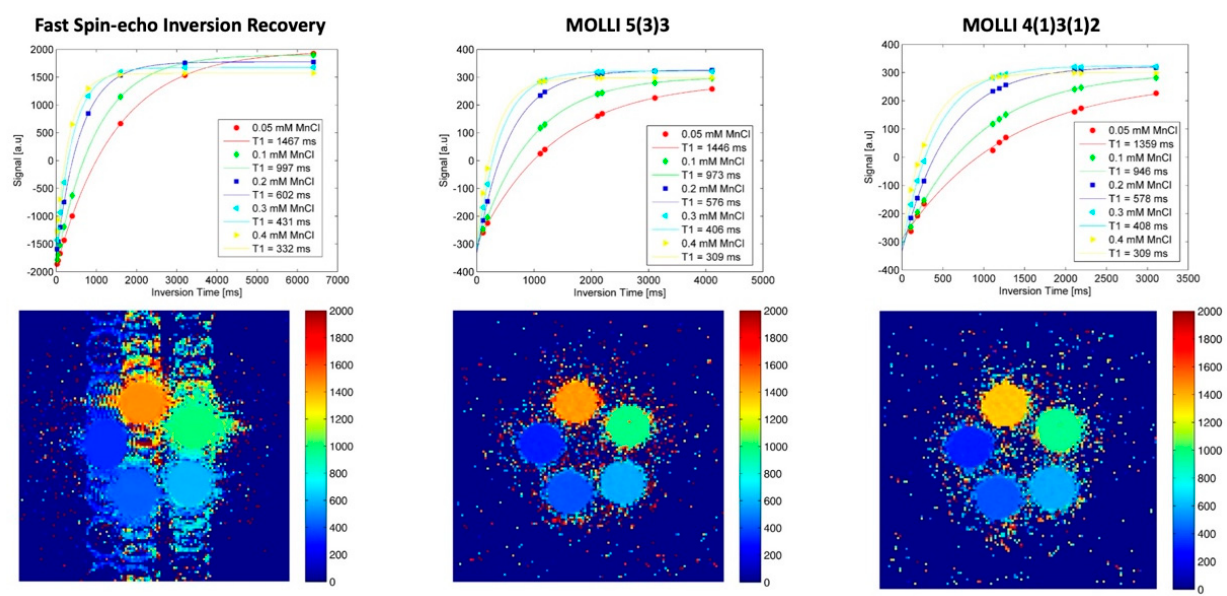
Figure 1. In vitro T1 mapping. As a standard of reference for different T1 relaxation times in the clinically relevant range, a phantom sample array with different concentrations of MnCl 2 was evaluated with an inversion recovery fast spin-echo (IR-FSE) sequence (left column). T1 evaluation with fitted curves and measured timepoints in the different samples is shown in the top row, with T1 maps including scale in the bottom row. Both MOLLI acquisition schemes (middle and right column) were compared with the same phantom setting.